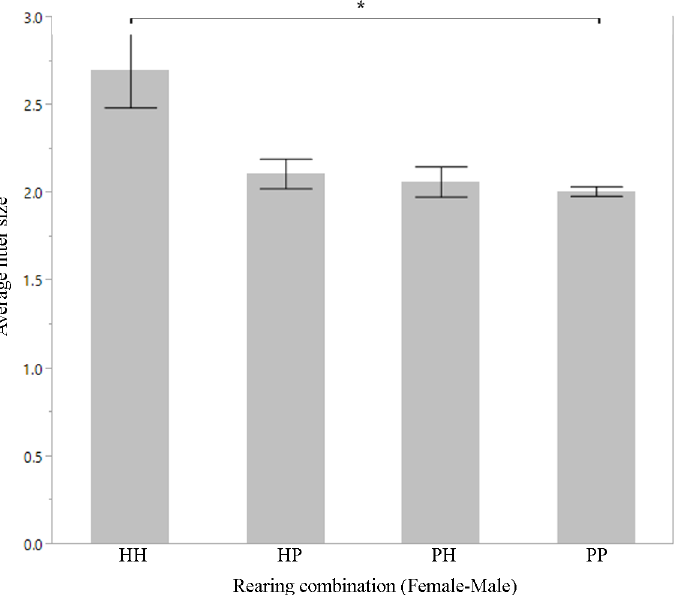
Fig 6. Mean number of individuals born to each dam and sire pair during a single reproductive event for snow leopards 1901 – 2011. Tukey's HSD post-hoc: * p < 0.05; ** p <